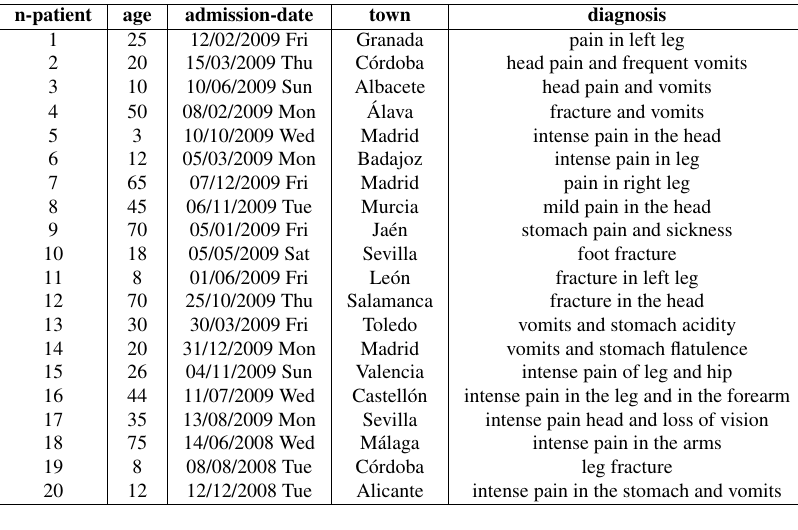
Table 1: Part of a table from a medical database